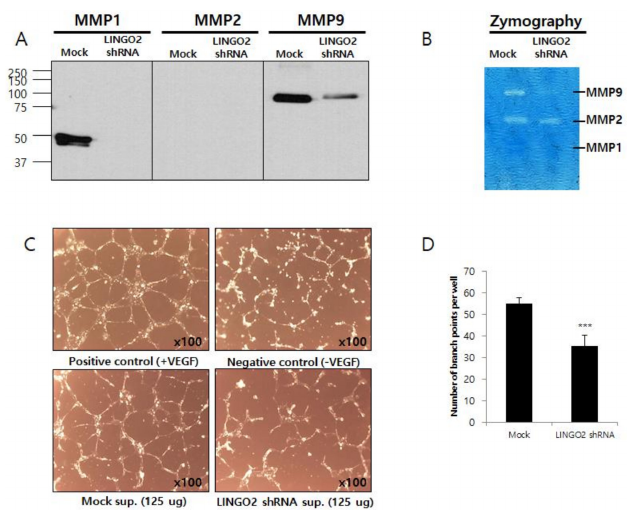
Figure 4. Silencing of LINGO2 reduces cell MMPs and human umbilical vein endothelial cells (HUVEC) tube formation ( A ) Reduced expression of MMP-1 and -9 proteins in the cultured supernatant and ( B ) active MMP-9 was observed in LINGO2 shRNA cells by western blot and zymography, respectively. ( C , D ) HUVEC tube formation was inhibited by LINGO2 shRNA culture supernatant by 35.6% ± 9.1% (*** p < 0.001).